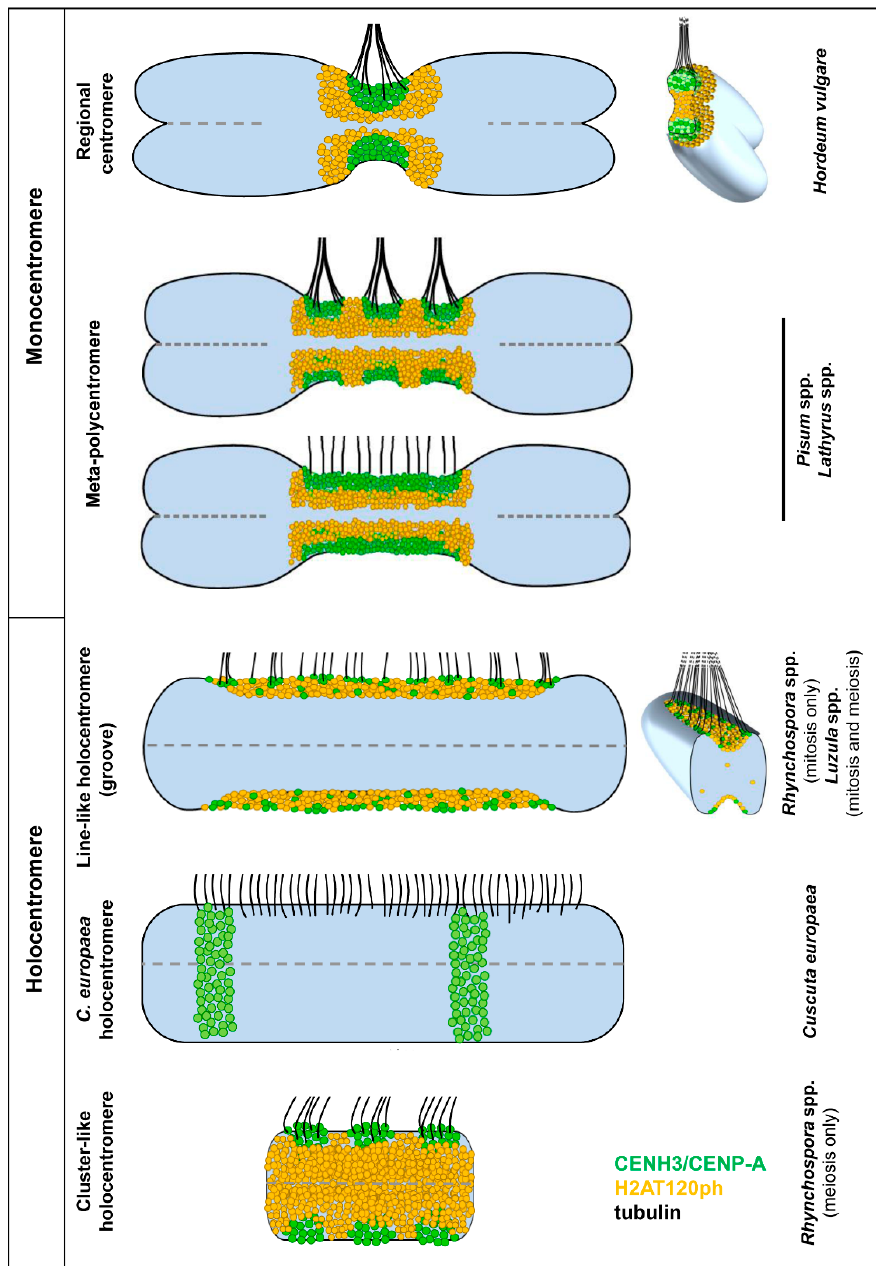
Figure 4. Models of the di ff erent mono- and holocentromere types appearing in di ff erent plant species indicate the possible centromere plasticity during mitosis and meiosis. The classification is based on the distribution of the spindle fibre attachment sites. In mono- and meta-polycentromeres, the microtubules (tubulin) form branching bundles and attach mainly at the flanks of the CENH3 / CENP-A clusters, but not at H2AT120ph. The bundle formation is less pronounced at holocentromeres. In line-like holocentromeres, spindle fibres attach mainly as single microtubules at the rim along the entire groove containing CENH3 / CENP-A and H2AT120ph, as is clearly visible in the cross-section [41]. The CENH3 / CENP-A-containing domains in meta-polycentromeres are usually well discernible (the upper model), but may also fuse into one line-like domain (bottom model). In C. europaea holocentromeres, the spindle fibres also attach to CENH3/CENP-A-free chromatin.